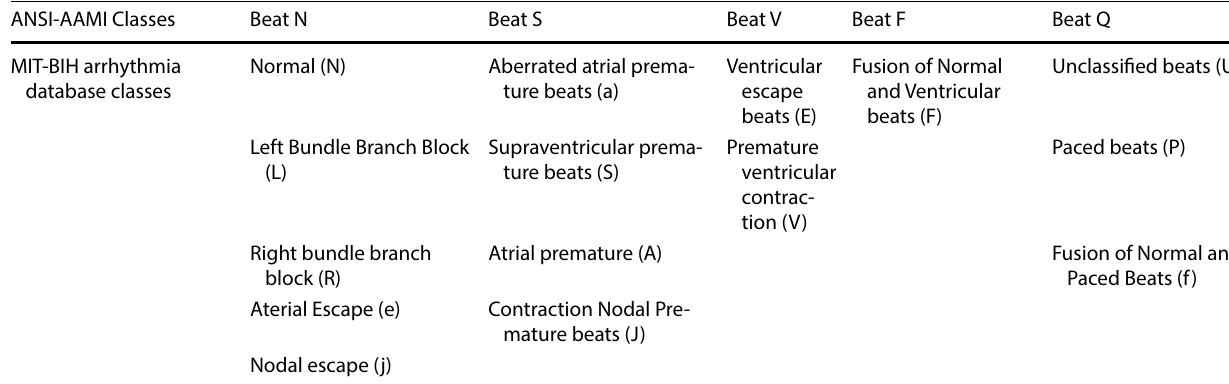
Table 1 The relation between ECG heartbeat labels to ANSI-AAMI Standards [29] ANSI-AAMI